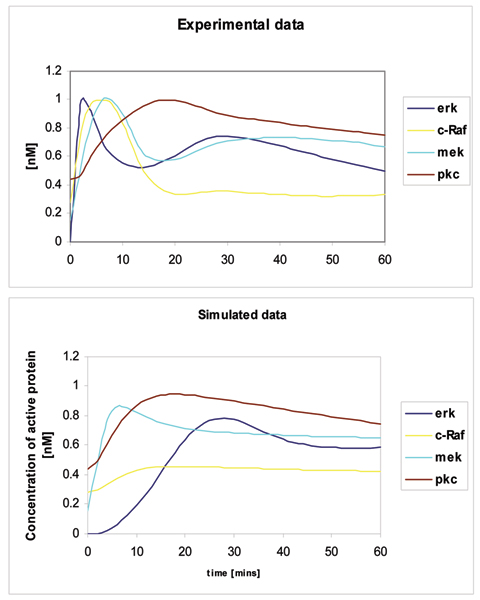
Simulated and experimental data. Comparison of experimental and simulated data. The experimental time courses of concentration for the proteins used as constraints in the calculation of the fitness function, is compared with the corresponding simulated behaviours.